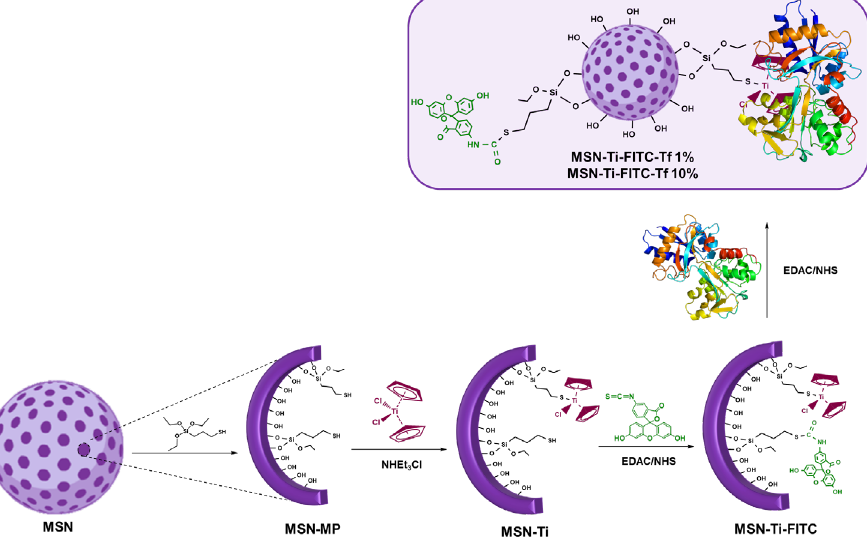
Figure 7. Preparation scheme of nanomaterials (purple sphere) functionalized with titanocene (organometallic compound in red), FITC (green molecule) and transferrin (multicolor macromolecule) [74]. Copyright © Authors of the publication (open access).